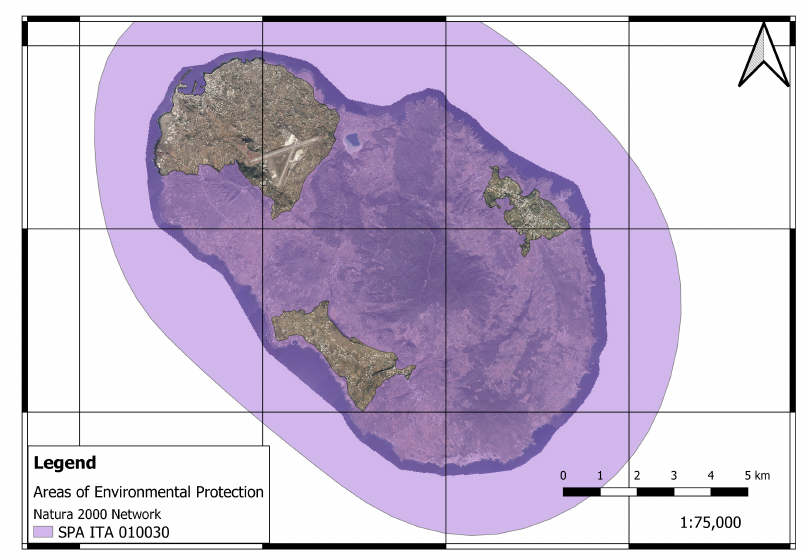
Figure 2. Special protected